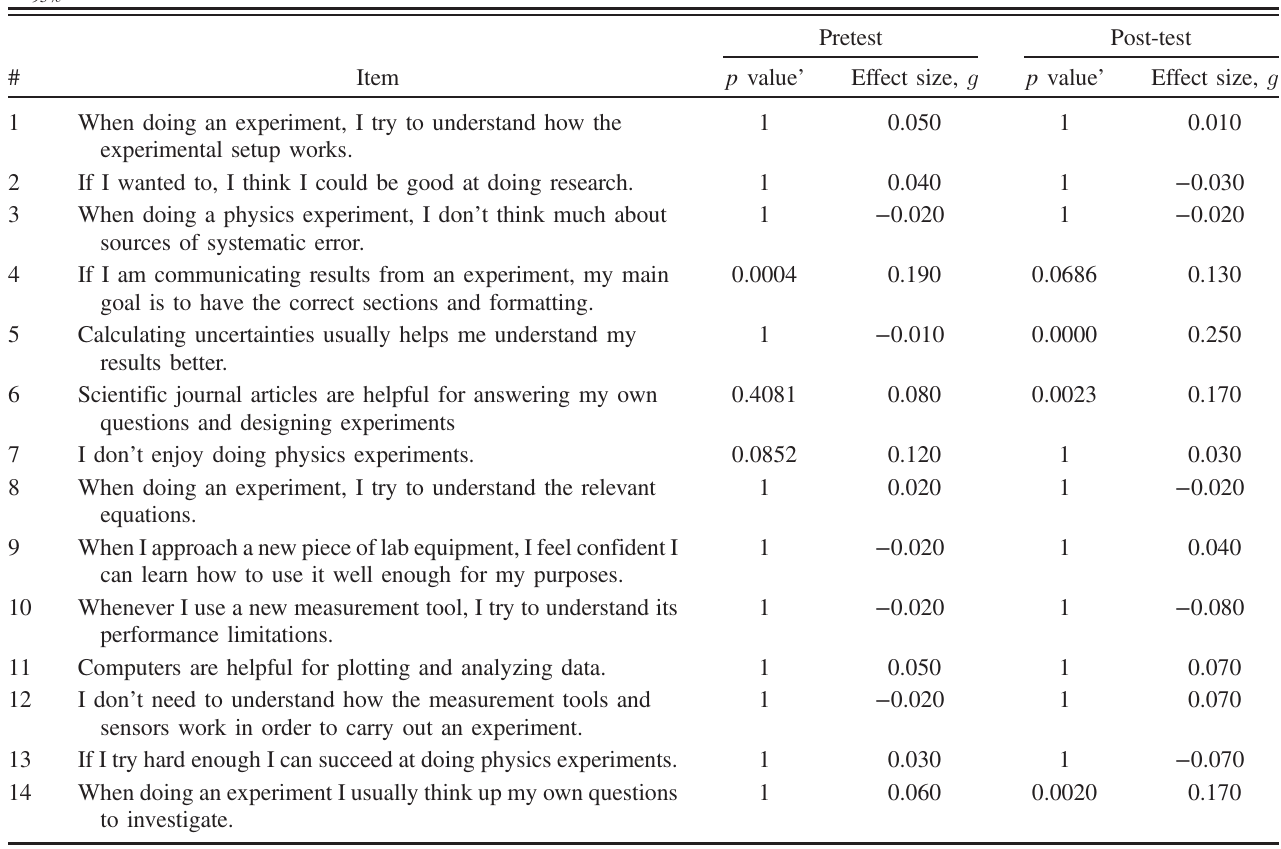
TABLE XIII. E-CLASS items on the pretest and post-test compared between BTand AT scores for men using a Mann Whitney U test. The p value has been adjusted using the Holm-Bonferonni correction. A positive effect size, in both pretest and post-test, indicates that the AT course had higher mean scores than the BT course. All effect sizes in this table have Ryan – Holm step-down Bonferroni corrected CI 0 95% ≤ 0 . 14